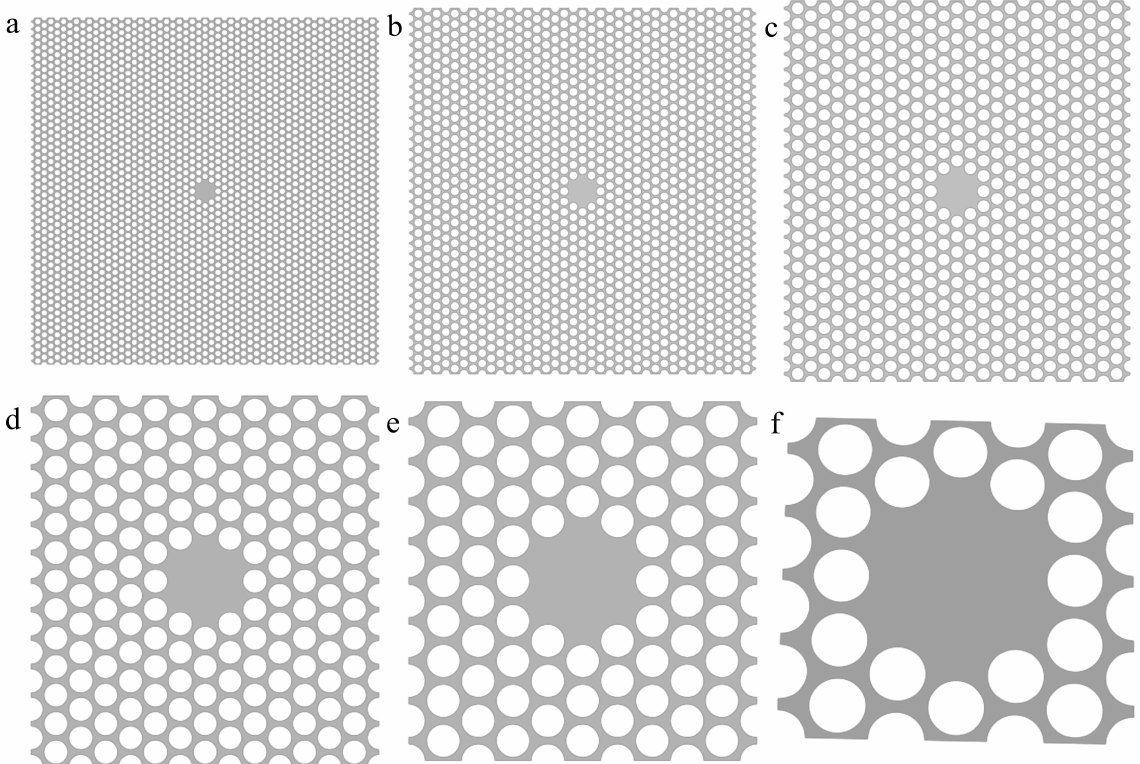
Figure 3. ( a–f ) The actual devices are consisting of 27 × 47, 19 × 35, 13 × 25, 7 × 13, 5 × 9 and 3 × 5 different-lattice-constants L but same-duty-cycle d / L cells with central defect areas, respectively, meanwhile fixing the overall width